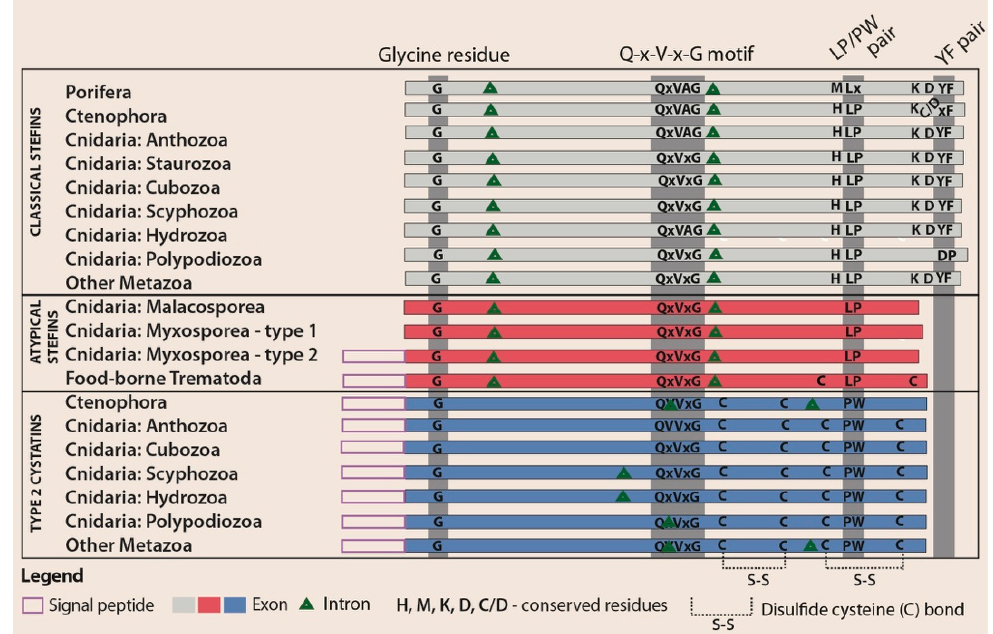
Figure 1. Repertoire of cystatin superfamily genes in early-emerging metazoan lineages.